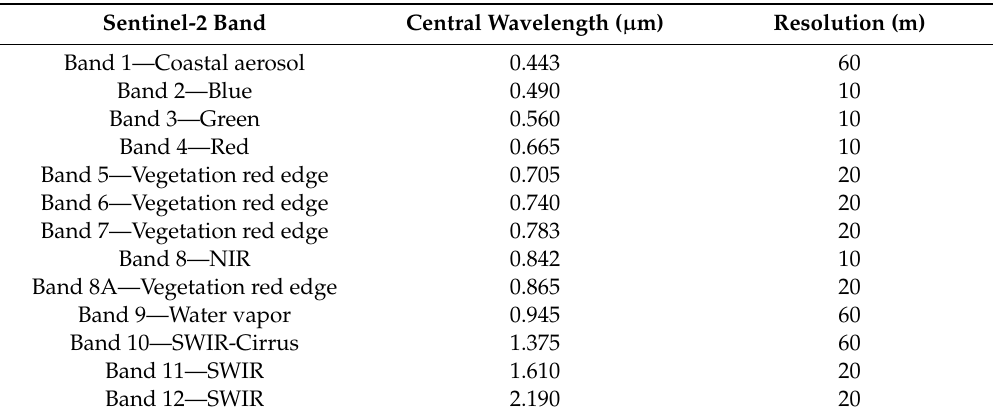
Table 1. Sentinel-2 band names, wavelengths, and